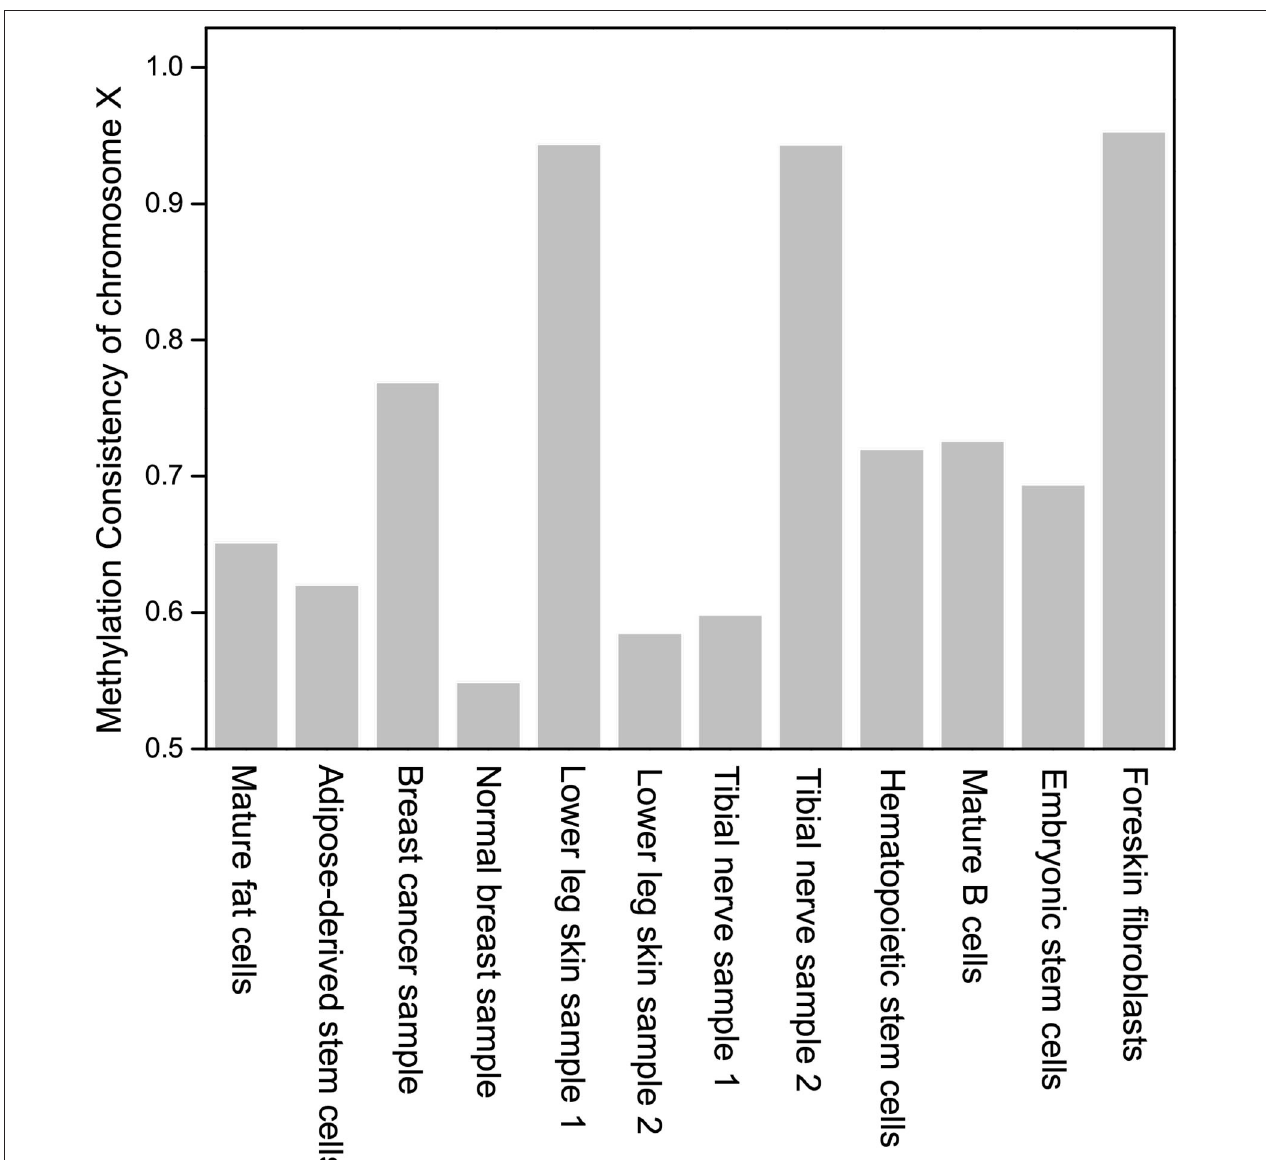
FIGURE 4 | The comparison of methylation consistency of chromosome X in different